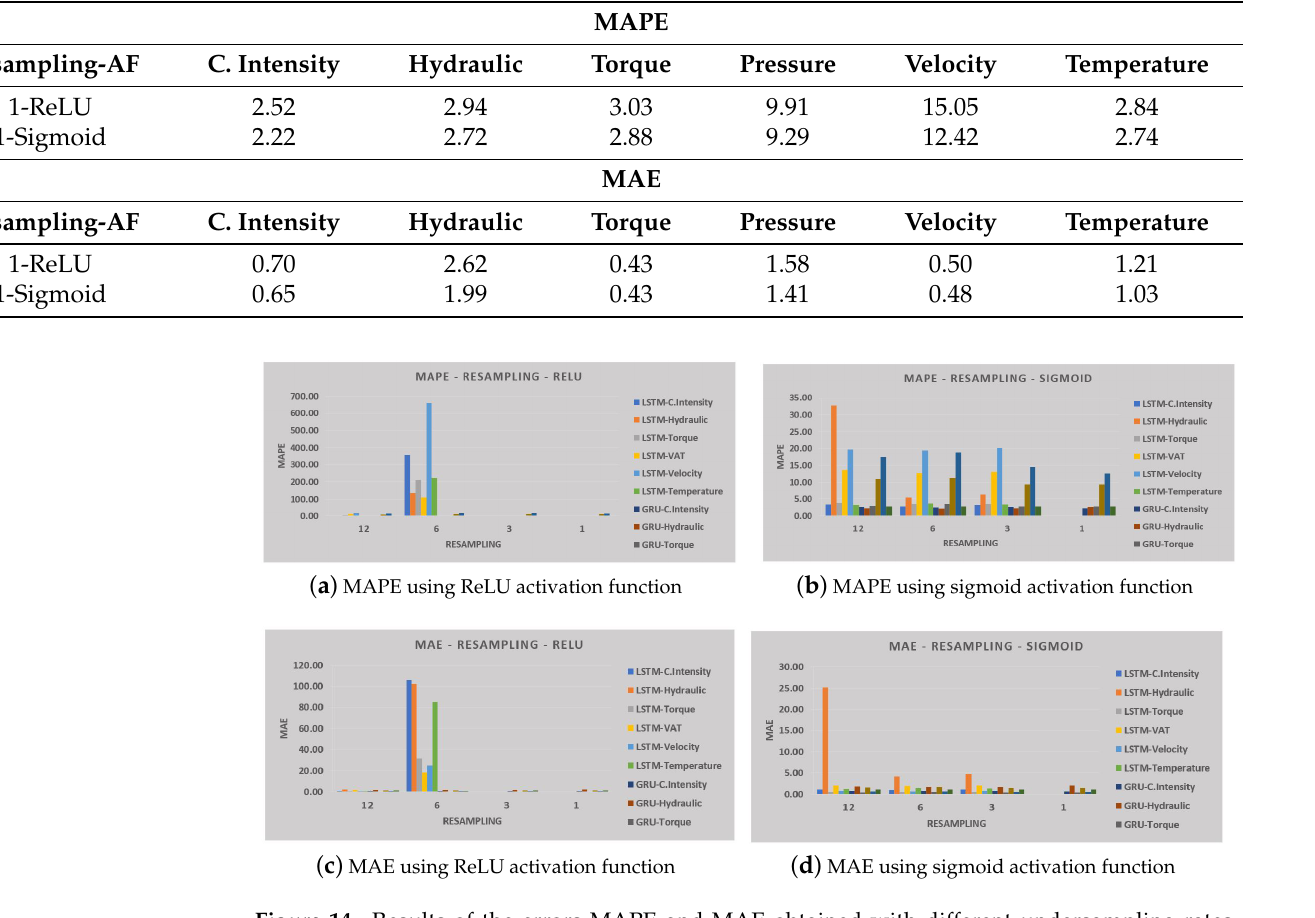
Figure 14. Results of the errors MAPE and MAE obtained with different undersampling rates, forecasting 30 days in advance.